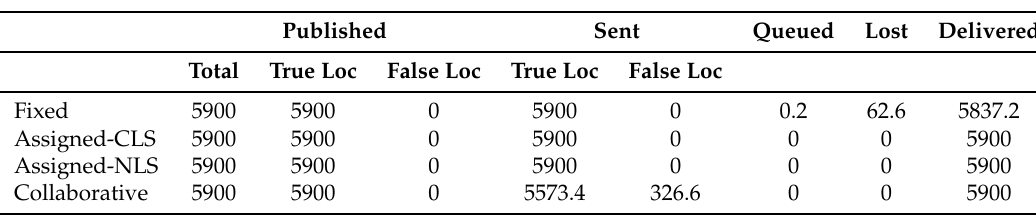
Table 2. Simulation statistics P f = 0. (a) Producer and network flow. (b) Delivered notifications with a true location claim. (c) Delivered notifications with a false location